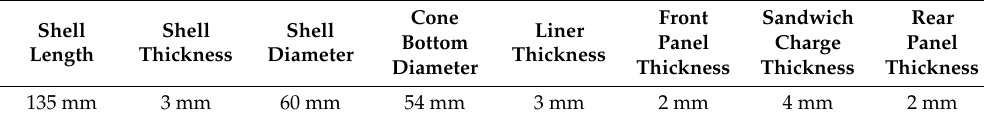
Table 1. Geometrical parameters of the entire model.